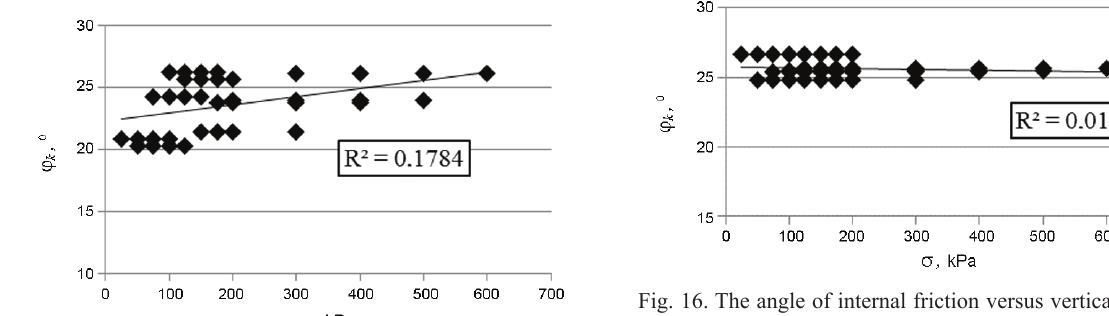
Fig. 16. The angle of internal friction versus vertical stress (results of 24 tests)